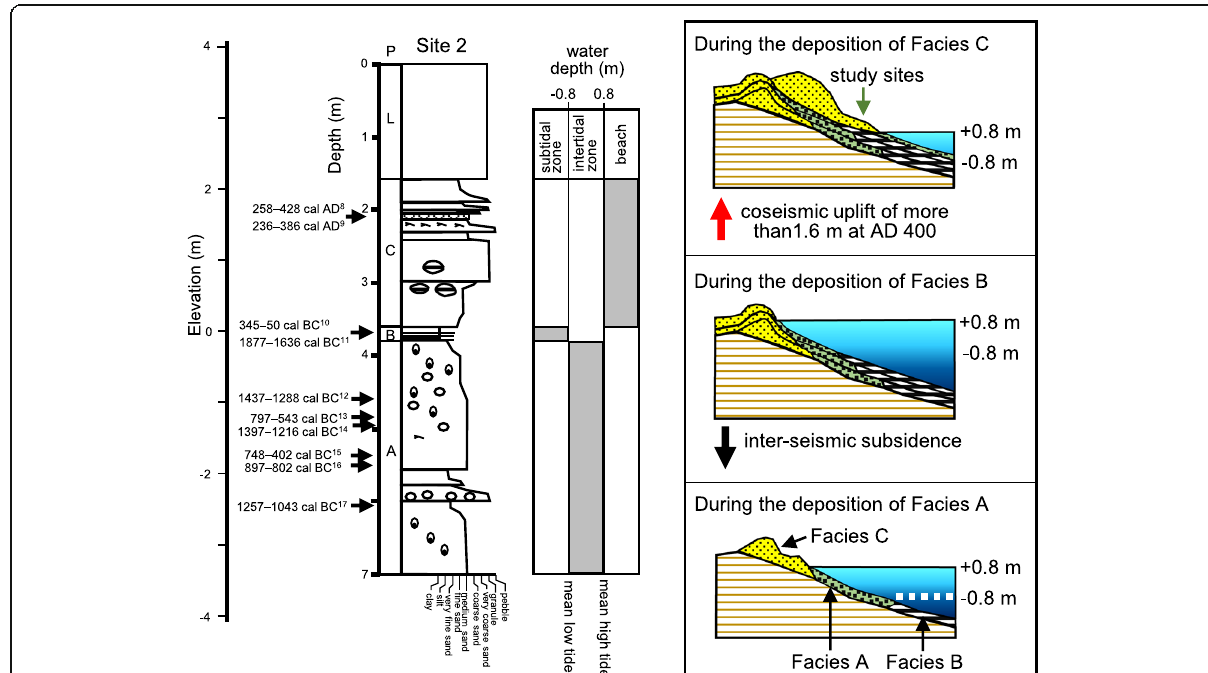
Fig. 9 Reconstruction of water-depth changes and depositional environments in the study area (Shimizu, central Japan) for the periods before and after the AD 400